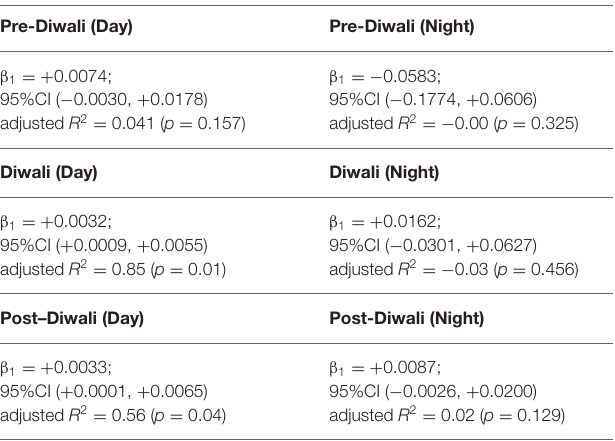
TABLE 2 | Summary of instrumental variable analysis (IVA) estimating causal effect of O 3 on f SOC . Pre-Diwali (Day) Pre-Diwali